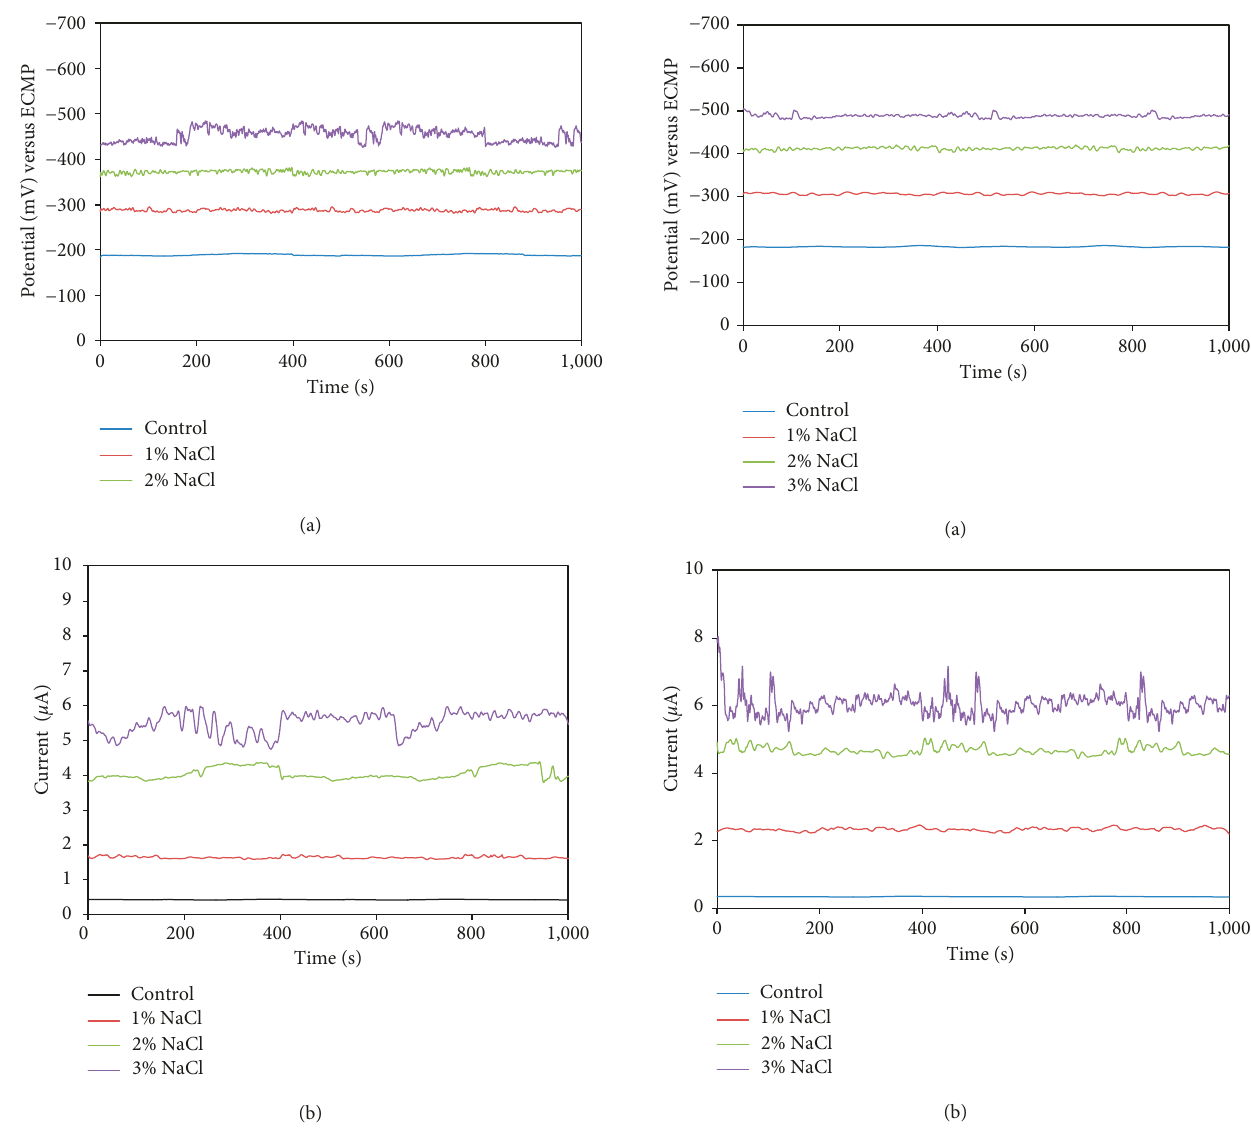
Figure 6: Time records of the potential (a) and current (b) signals for the prestressed steel in chloride-contaminated